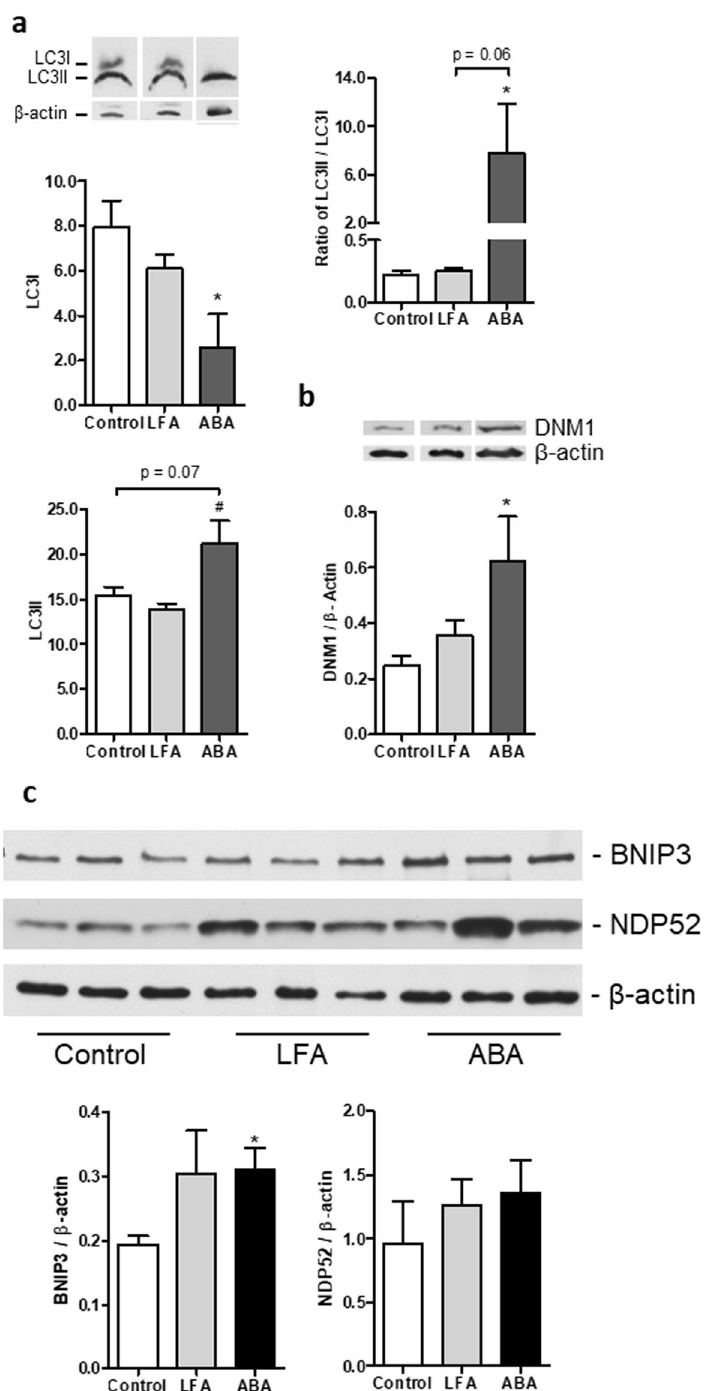
Figure 7. Hypothalamic autophagy at day 17. ( a ) Representative immunoblots (n = 1/group) and expression profile (n = 6/group) of LC3I, LC3II at d17 (Supplemental Fig. S8) and ( b ) representative immunoblots (n = 1/ group) and expression profile (n = 6/group) of DNM1 at d17 in the hypothalamus of Control mice (open bars) or mice with limitation of food access (LFA, grey bars) or activity-based anorexia (ABA, black bars). ( c ) Representative immunoblots (from 3 individuals/group) and expression profile (n = 6/group) of BNIP3 and NDP52 at d17 in the hypothalamus of Control mice (open bars) or mice with limitation of food access (LFA, grey bars) or activity-based anorexia (ABA, black bars). * p < 0.05 vs Control. # p < 0.05 vs